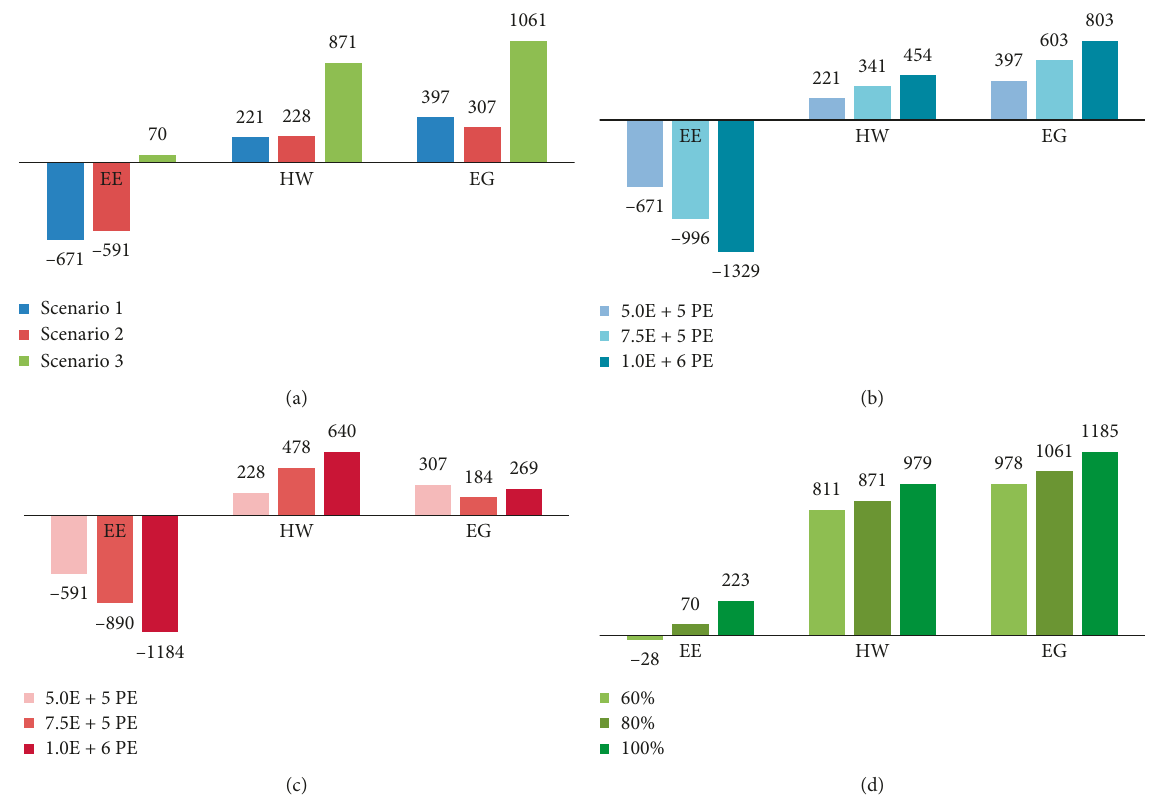
Figure 3: Plant-wide net energy (kWh) including thermal (HW and EG) and electrical power (EE) in (a) scenarios 1, 2, and 3; (b) scenario 1 at different plant sizes; (c) scenario 2 at different plant sizes; and (d) scenario 3 with different % of OFMSW